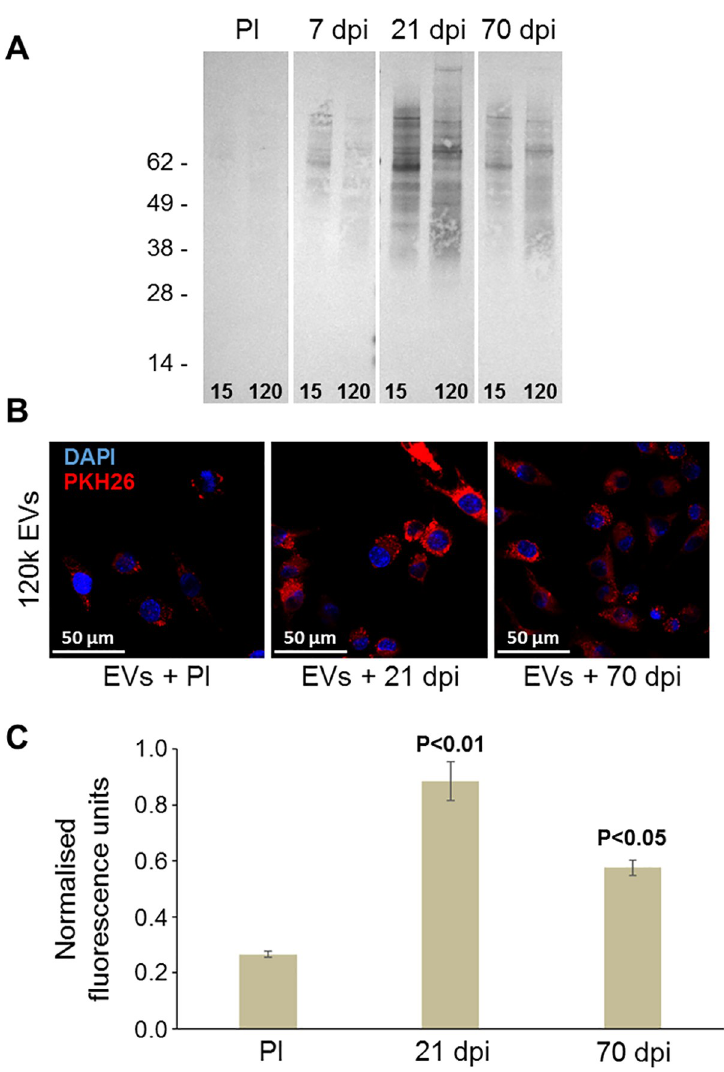
Fig 8. Host antiserum enhances internalisation of F . hepatica EVs by macrophages. (A) Immunogenicity of F . hepatica EVs in F . hepatica -infected rats. Equal amounts (10 μ g total protein) of 15k and 120k EVs were analysed by Western blot using pre-infection (PI) sera and serum samples taken 7, 21 and 70 days post-infection. (B) RAW264.7 macrophages were incubated with PKH26-labelled 120k EVs for 3 h at 37˚C and the cells were analysed by confocal microscopy. EVs pre-incubated with pre-infection rat serum were internalised by the macrophages as shown by the punctate red fluorescence observed throughout the cytoplasm. However, when EVs were pre-treated with 21-day rat serum the internalisation the EVs increased considerably. A similar, but less dramatic, effect was observed when EVs were pre-treated with the 70-day serum. Nuclei were stained with DAPI (blue). (C) These effects were statistically significant when measured as fluorescence intensity relative to cells treated with EVs pre-incubated with pre-infection